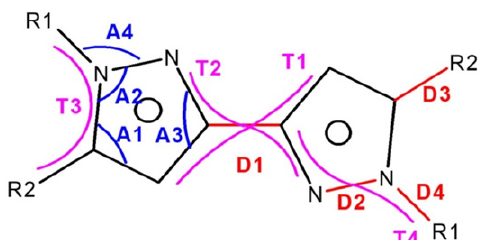
Fig. 5. The parameters selected to describe the geometry of bipyra- zole